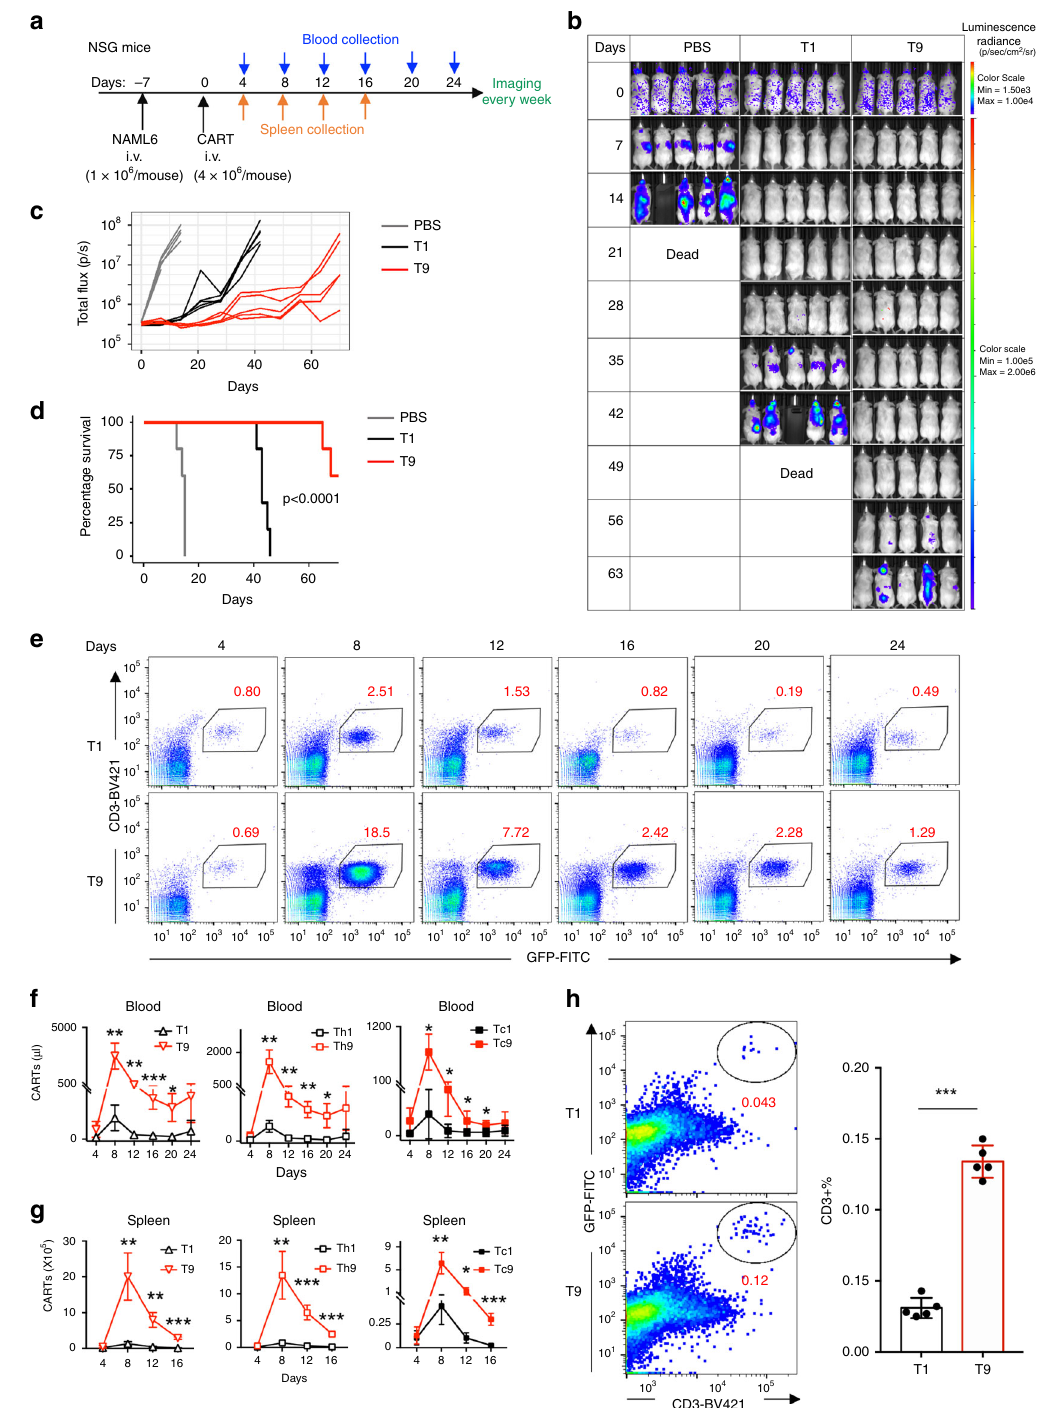
Fig. 4 T9 CAR-T cells exhibit enhanced antitumor activity against established tumor in vivo. a NSG mice were intravenously injected with 1 × 10 6 NALM6 cells. Seven days later, mice were randomly assigned to three groups and were infused intravenously with 4 × 10 6 CD3 + CAR-T cells. b Tumor burden measured by bioluminescence at indicated days since CAR-T cell infusion. c Tumor burden (total fl ux) quanti fi ed by photons/s in mice treated with PBS or CAR-T cells at indicated days since CAR-T cell infusion. d Kaplan – Meyer plot showing mouse survival. Exact p values from log-rank test are shown for T1 versus T9 CAR-T cell-treated mice, and data shown are representative of two independent experiments. e Representative fl ow plots showing the frequency of CD3 + CAR-T cells in blood of treated mice at day 8 after CAR-T infusion. Total number of CD3 + CAR-T cells in f blood ( n = 5 mice) or g spleen ( n = 4 mice at day 4, n = 5 mice at other days) of treated mice at different days since CAR-T infusion. h Percentage of bone marrow-in fi ltrating CAR-T cells identi fi ed by CD3 + GFP + T cells at day 8 after transfer. Representative plots (left panels) and summarized results ( n = 5 mice; right panels) are shown. Data are presented as mean ± SD. * P < 0.05, ** P < 0.01, and *** P < 0.001, two-sided Student ’ s t -test. Source data are provided as a Source Data fi